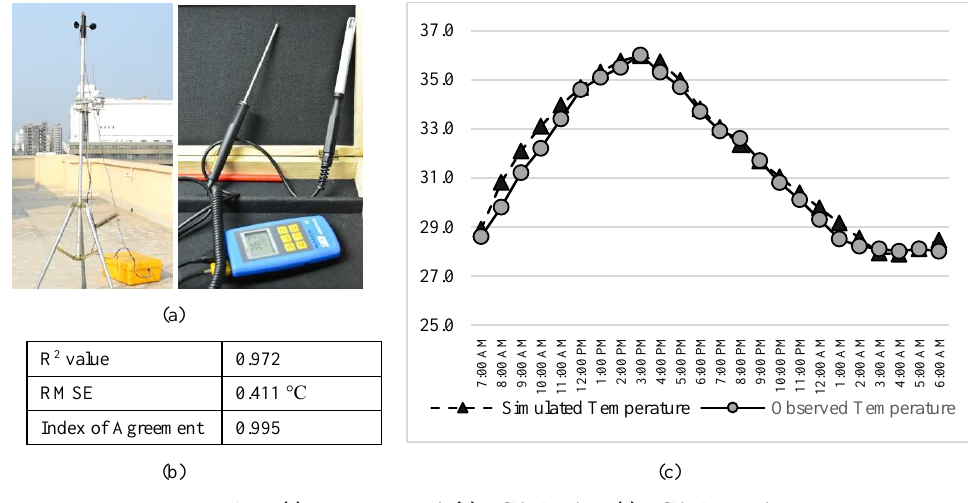
Fig. 3. (a) Instruments used, (b) Validation data, (c) Validation